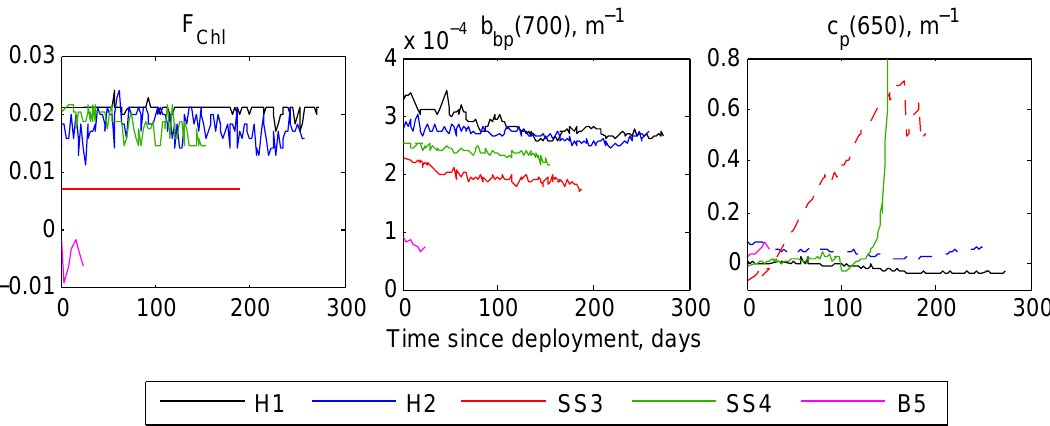
Fig. 2. Long-term changes in deep-water values for sensors on each of the five floats. Left panel: chlorophyll fluorescence. Offsets among floats are primarily due to imperfect calibration and are close to detection limits. Middle panel: b bp (700). Offsets among floats are likely due both to small differences in initial calibration coefficients and to differences in deep particle concentrations. Right panel: c p (650). Dashed lines show floats with “rinsing hose” configuration (see text); solid lines without. Initial differences are due to instrument calibration and variability in deep attenuation values; subsequent drift is likely due to biological fouling (float SS3–SS4) and/or changes in deep-water attenuation (floats